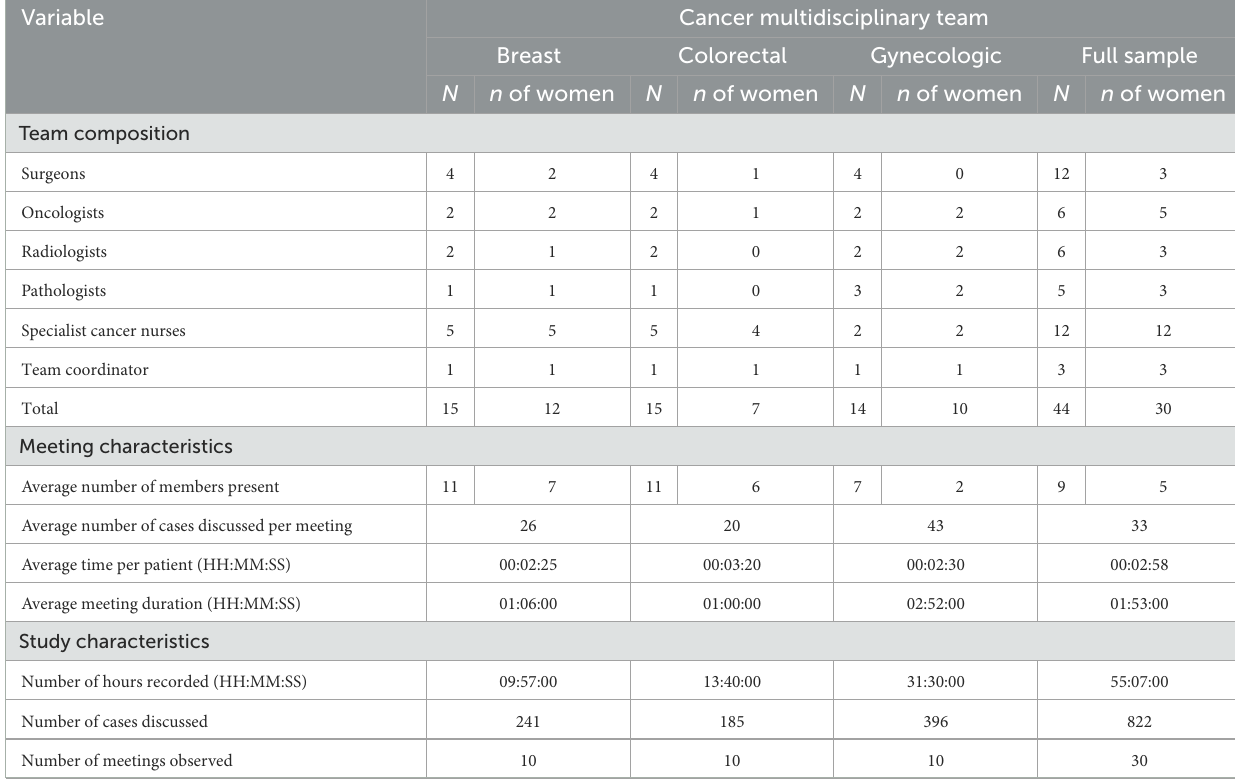
TABLE 1 Team composition and meeting characteristics of participating cancer multidisciplinary teams.